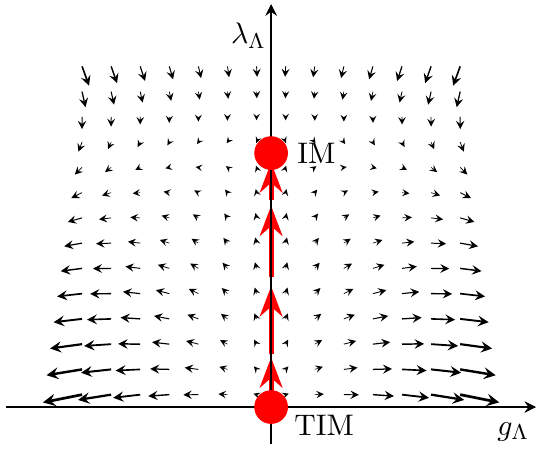
Figure 4.1: Vector fields ( β